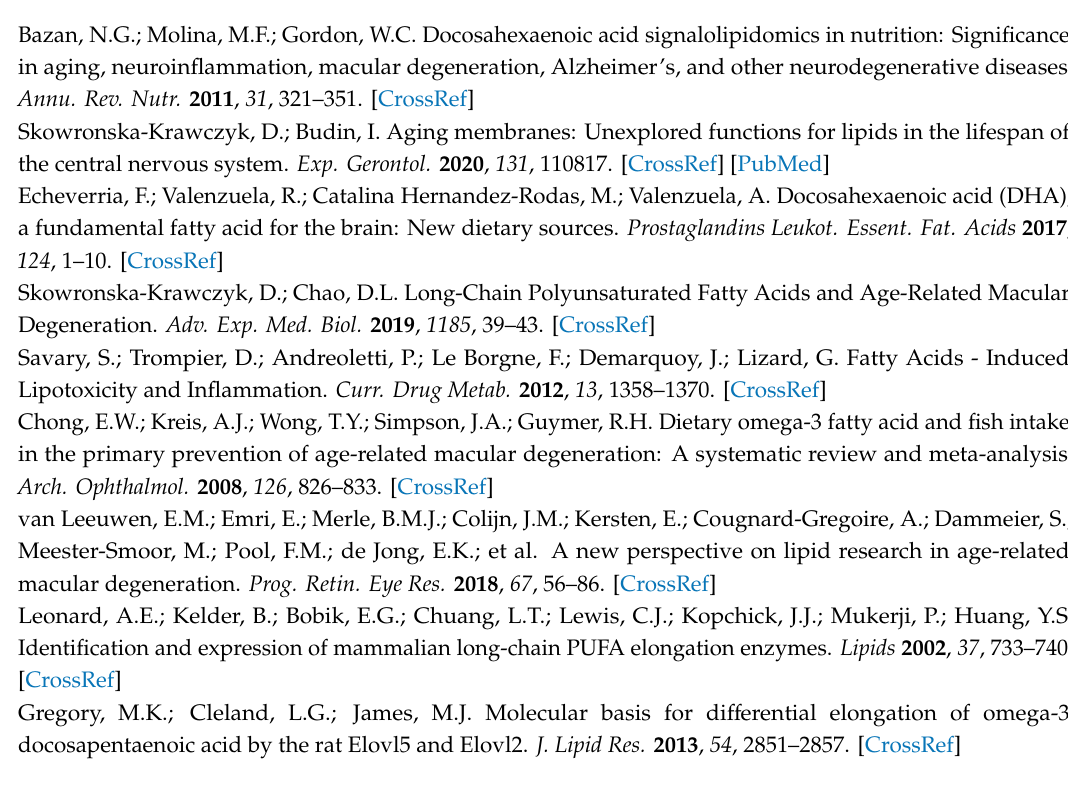
sequence alignment of ELOVL2 protein in di ff erent species showing conserved sequences. Amino acids forming transmembrane helices are highlighted in red; * represents identical amino acids; represents amino acids with highly similar properties; represents amino acids with weakly similar properties. Supplementary Figure S2 Expression of elovl2 in adult zebrafish retina. Expression analysis of elovl2 in 3 months (Panel A) and 14 months (Panel B) old zebrafish retina showing brightfield (A, B), DAPI stained (A’,B’), elovl2 stained (A”,B”) and overlay (A”’,B”’) images. Scale bars indicated. Supplementary Figure S3 . Sequence analysis of elovl2 and control crispants at exon 2 and exon 3. A. Schematic of elovl2 gene structure and location of gRNAs with sequence in exon 2 and exon 3 used in this study. B. Representative sanger sequencing traces showing gene editing at the cut site. C. ICE analysis of indel distribution of a representative zebrafish embryo of elovl2 gRNA on exon2. Note cumulative frameshift indel of 91% D. ICE analysis of indel distribution of a representative zebrafish embryo of elovl2 gRNA on exon 3. Note cumulative frameshift indel of 87%. Supplementary Figure S4 . Heatmap of all the identified lipids on whole zebrafish embryo (day 2) and on embryos eyes (day 7). Supplementary Figure S5 . The relative abundance of each lipid class of control and elovl2 crispants. Supplementary Figure S6. A. Representative H&E staining images of elovl2 and control crispants showing di ff erent layers of retina. Scale bars = 100 µ m. B. Table with data presented in Figure 3B. Supplementary Figure S7 . Expression of Elovl2 in Muller glia. A. Overlap of elovl2 and glula signals detected by RNAscope confirms that elovl2 is expressed in Muller glia. *—autofluorescence B. Expression of elovl2 and Muller glia marker detected in crispens—lower level of elovl2 is noted in crispants. No changes in glula expression can be detected. Scale bars indicated. Supplementary Figure S8 Comparison of staining intensity with elovl2 and control probe. The negative control probe (Panel A) showed light autofluorescence in photoreceptor layer (A’) confirming specific staining of elovl2 (B’) in the three-month-old retina (Panel B). Scale bars = 50 µ